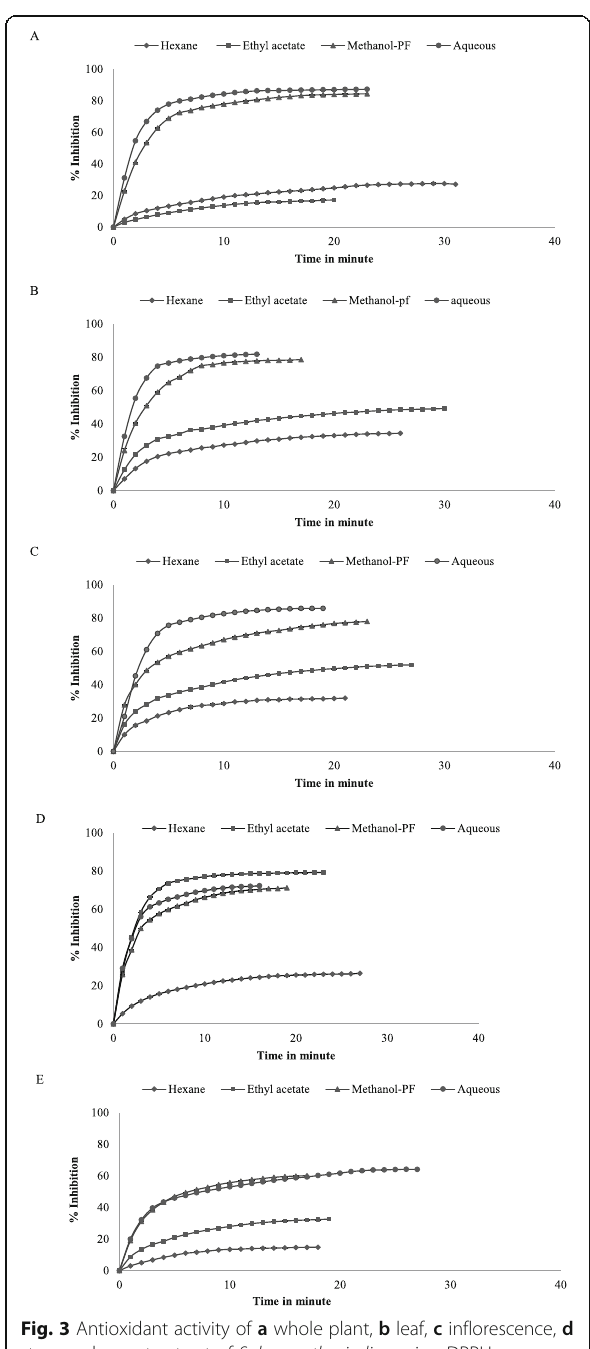
Fig. 3 Antioxidant activity of a whole plant, b leaf, c inflorescence, d stem and e root extract of Sphaeranthusindicus using DPPH assay over timeand comparison between parts and